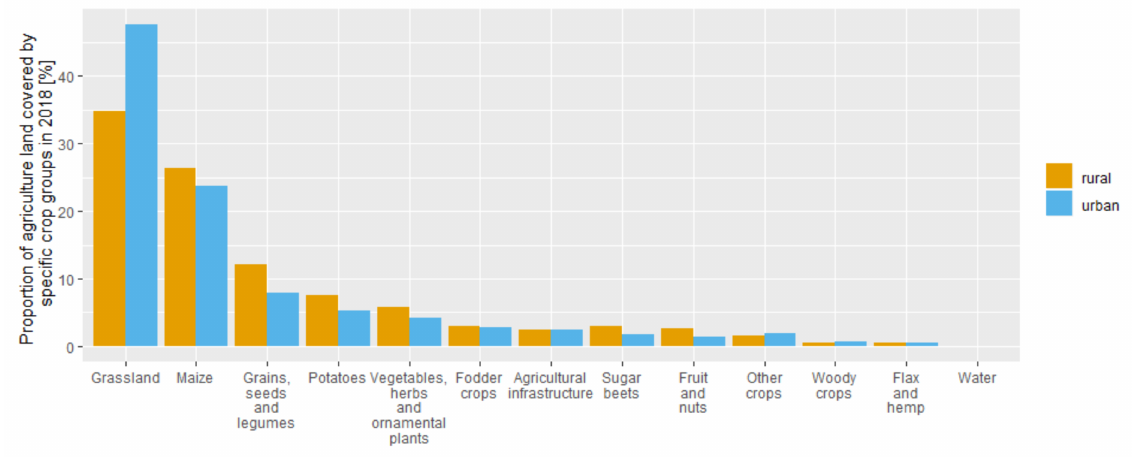
Figure 2. Proportion of urban (blue) and rural (orange) agricultural land covered by specific crop groups (LCcrop) in 2018. (Data source: